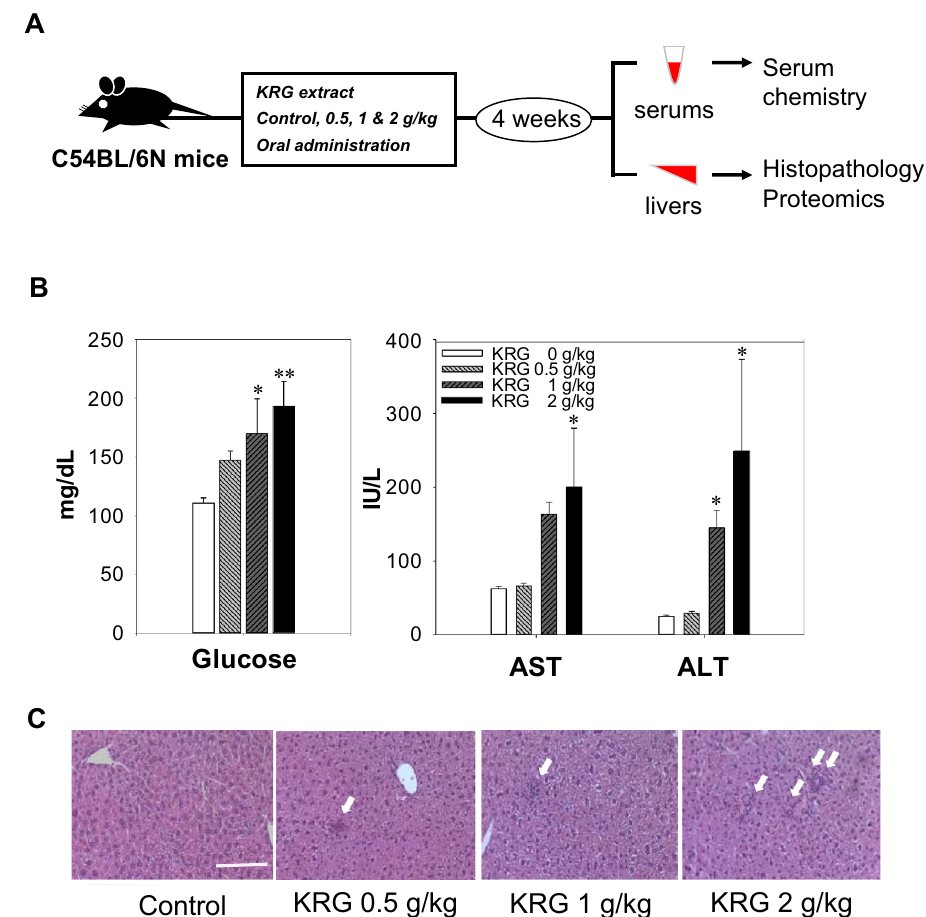
Figure 1. Overview of the experimental approach. Five-week-old C57BL/6 N male mice were orally administered different doses (0.5 g, 1.0 g, and 2.0 g/kg) of Korean red ginseng (KRG). After 4 weeks, serum and liver tissue were extracted for serum chemistry and proteomic analysis ( A ). Glucose levels and AST and ALT levels in the serum ( B ). Histological analysis of H & E staining of liver tissue at 200 × magnification. White arrows indicate inflammatory cell infiltration. Scale bar represents 150 mm. ( C ). Results are shown as the mean ± SEM of five to six animals per group. Statistical significance was set at * p < 0.05 and ** p < 0.01 compared with the control based on an ANOVA (SPSS Statistics 23 software package, https:// www. ibm. com/ analy tics/ spss- stati stics- softw